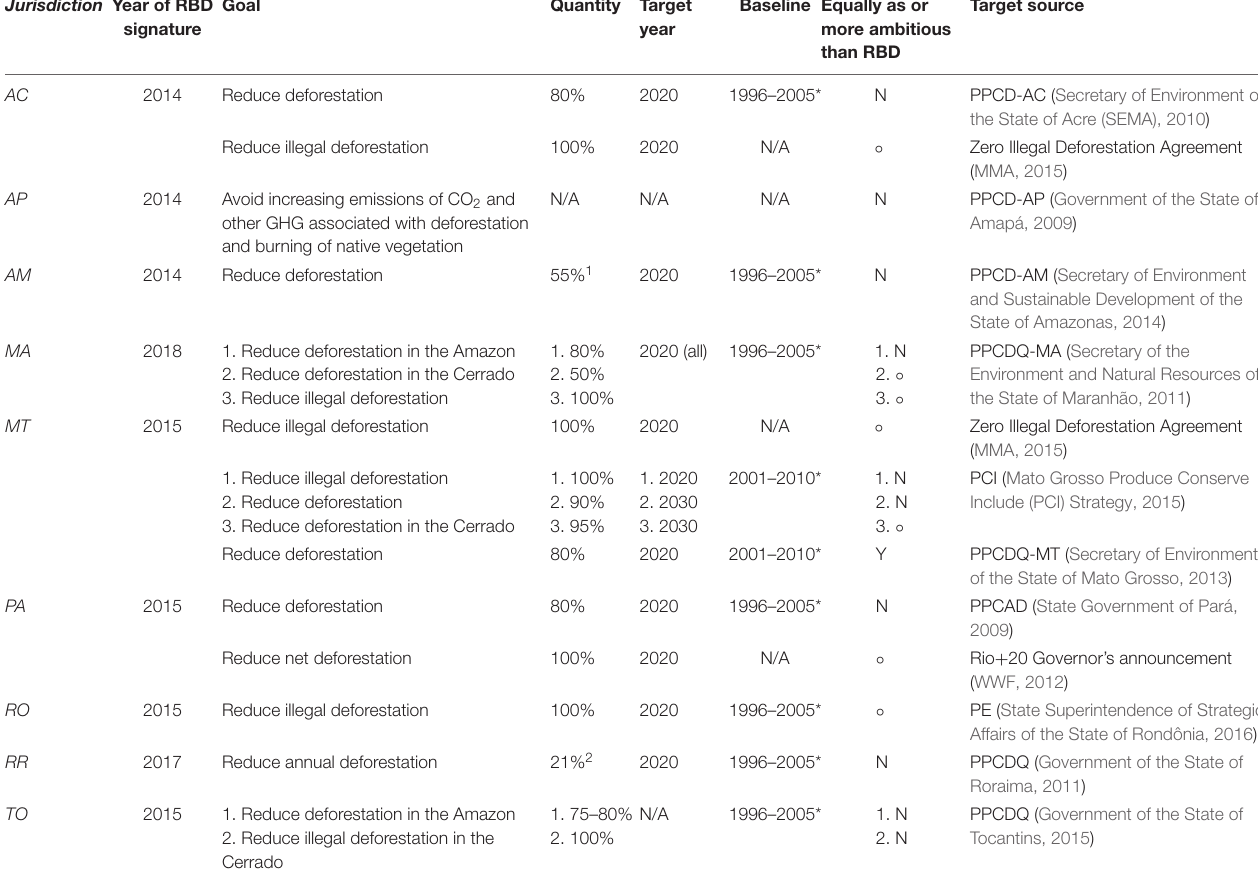
TABLE 2 | Inventory of deforestation targets (“legal targets”) of the nine GCF TF member jurisdictions located in Brazil. Jurisdiction Year of RBD signature